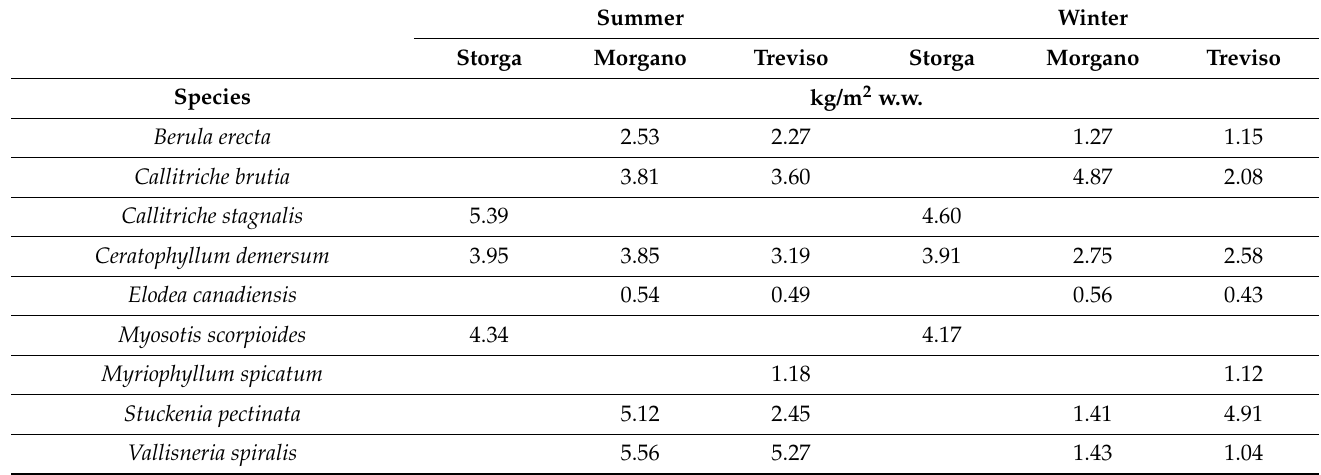
Table 1. List of submerged aquactic macrophytes (SAMs) and Biomass (kg/m 2 wet weight). Summer Winter